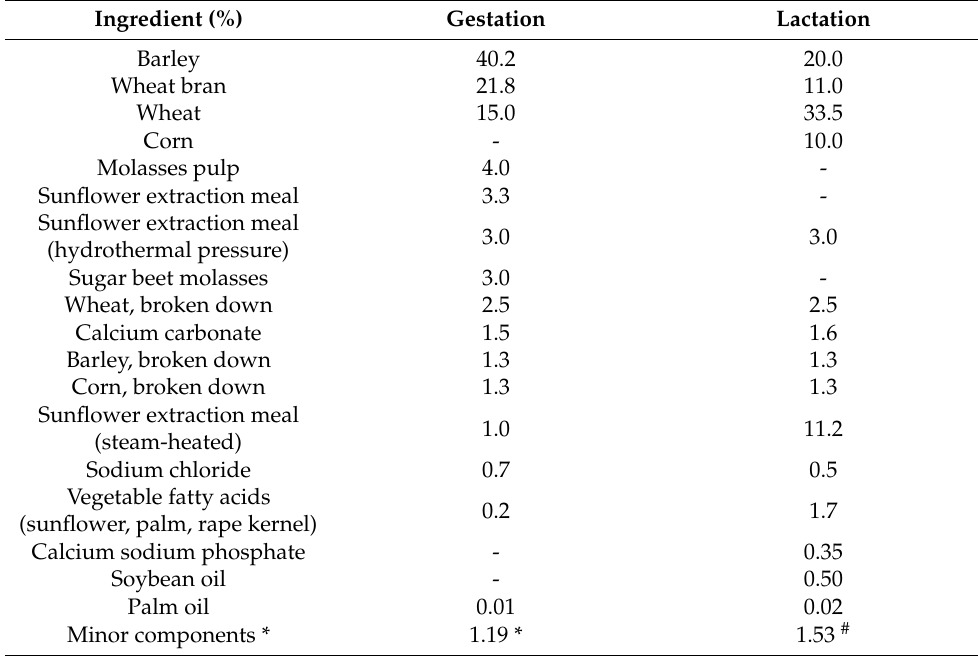
Table 1. Ingredient composition of the basic diets.